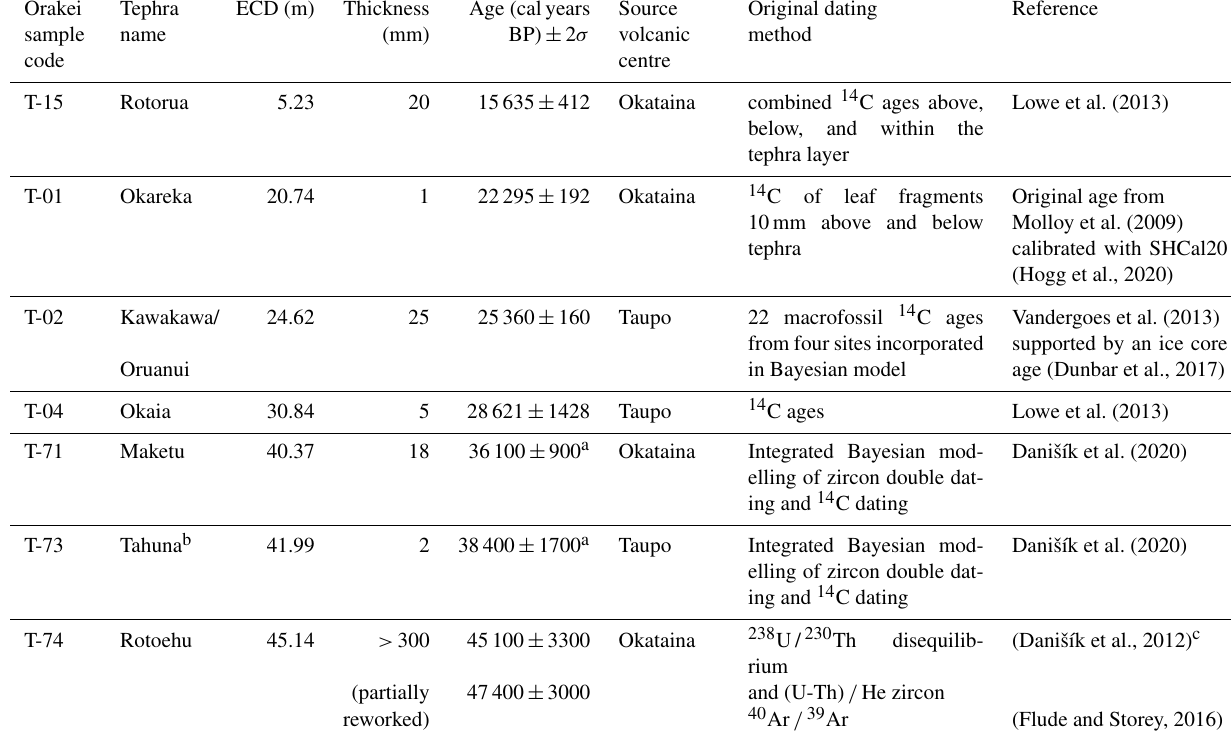
Table 2. Identified rhyolitic tephra layers in the Orakei sediment sequence. For source locations see Fig. 1. Orakei